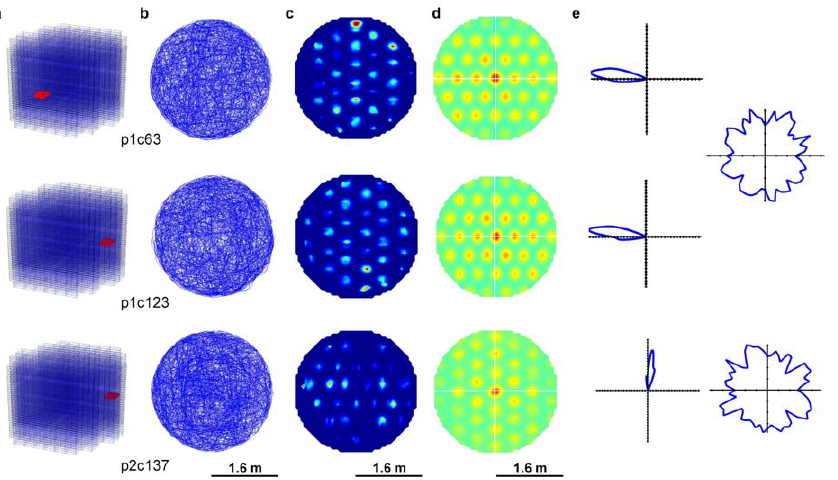
Figure 4. Cell firing field spacing and orientation was constant within the network. (a) The recorded cell locations. (b) The robot trajectories. (c) Cell firing fields (d) Firing field auto-cross correlations are shown. Firing field phase varied within the cell network, with only a few cells required to completely cover the environment. (e) Polar plots showing directional tuning of cells (left) and duration of time spent at each head direction (right). The first two rows show results for two cells from the same network, the third row shows a cell from a network with a different fundamental grid orientation.